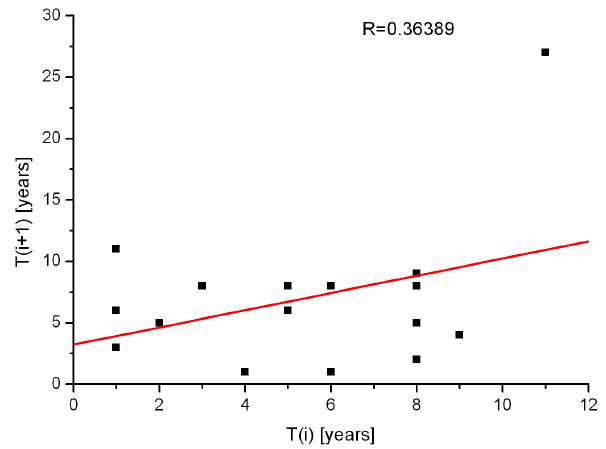
Fig. 3. Independence check for Nevados de Chill´an, restricted erup- tion record from 1860 onwards. The scatter plot shows each repose time plotted against the preceding repose time. The points are rela- tively evenly distributed, and no clear correlation is evident. This is in agreement with the correlation coefficient R = 0 . 364, consistent with uncorrelated data. The square of the correlation coefficient (the coefficient of variation) is R 2 = 0 . 132, with the intuitive interpreta- tion that at most 13% of the variation observed in the repose times can be explained by the variation in the preceding repose